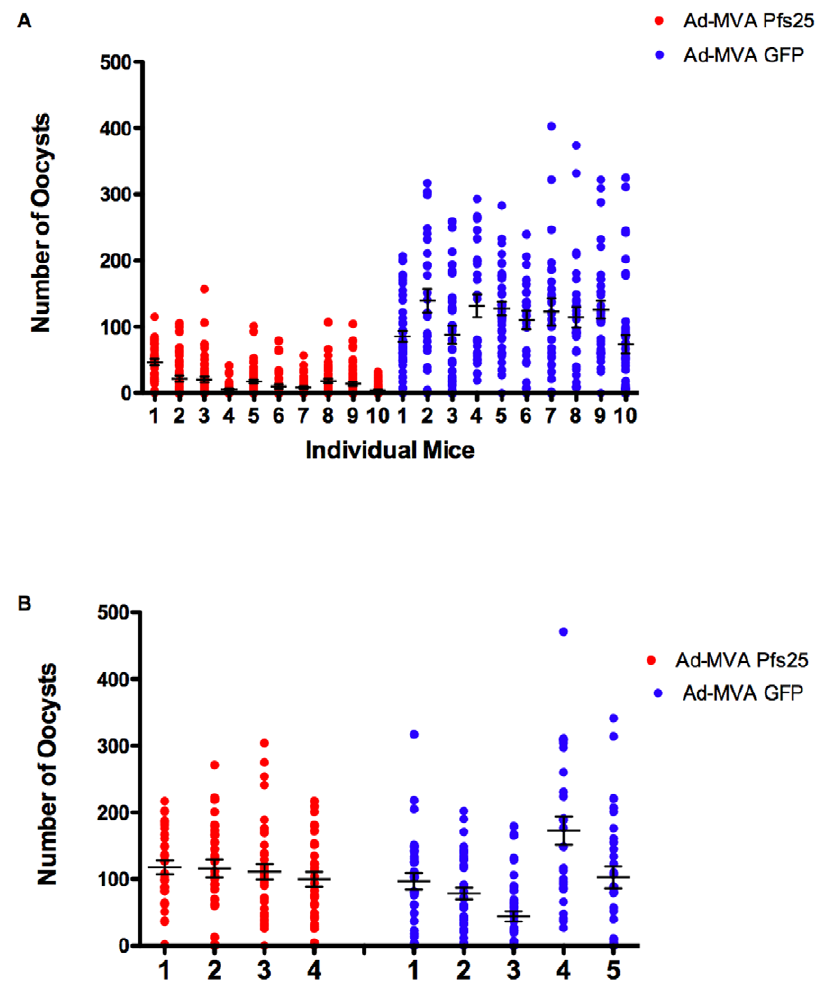
Figure 4. Parasite infectivity (per mosquito) following Ad-MVA Pfs25 immunization. BALB/c mice were immunized with Ad-MVA Pfs25 (red) as figure 1a or Ad-MVA GFP (blue) a GFP-encoding control. Mice were divided into two groups and infected with ( A ) Pfs25DR3 (10 per group) or ( B ) wild-type P. berghei (5 per group) and used to assess transmission to mosquitoes. Mosquito midguts were examined 12 days post-feeding. Data points represent mosquitoes that fed on individual mice. X-axis points represent individual mice. Horizontal lines indicate the mean number of oocysts for each mouse ( + / 2 sem).